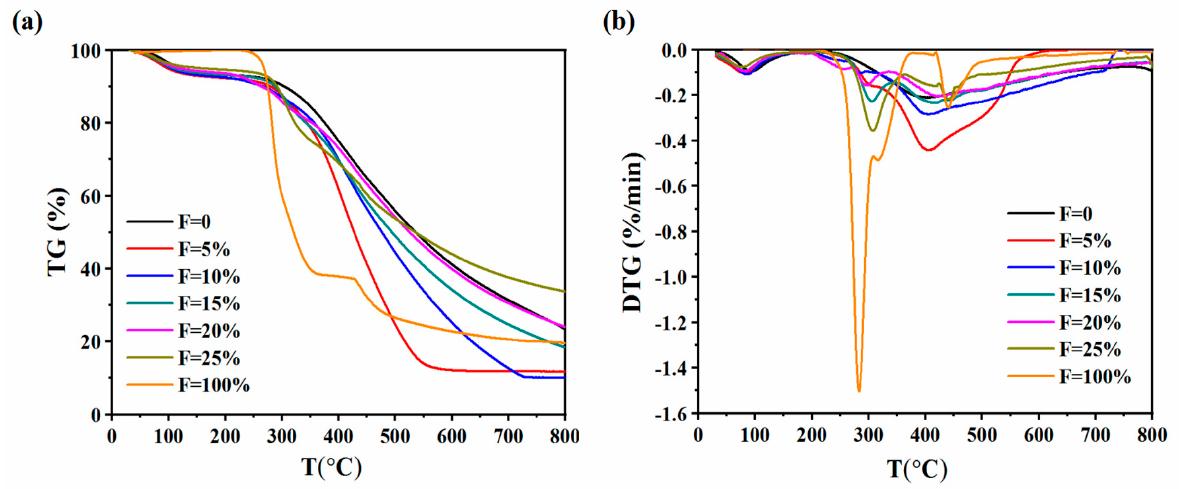
Figure 2. TG and DTG curves of HLE pyrolysis with different PVC additions. ( a ) TG, ( b ) DTG.